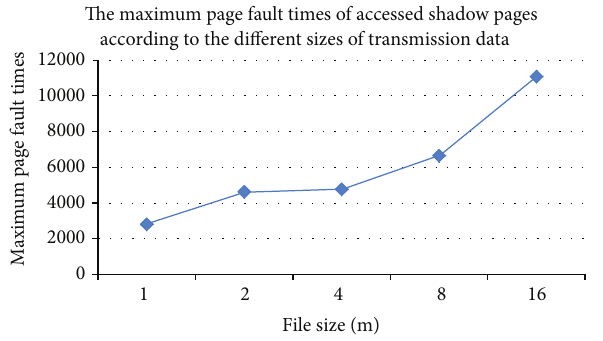
Figure 3: When a driver which is isolated by Chariot with DWC algorithm transmits different sizes of data, the distribution of the maximumpagefaulttimesofaccessedshadowpages.Themaximum page fault times mean the maximum number of page faults in the whole shadow pages.